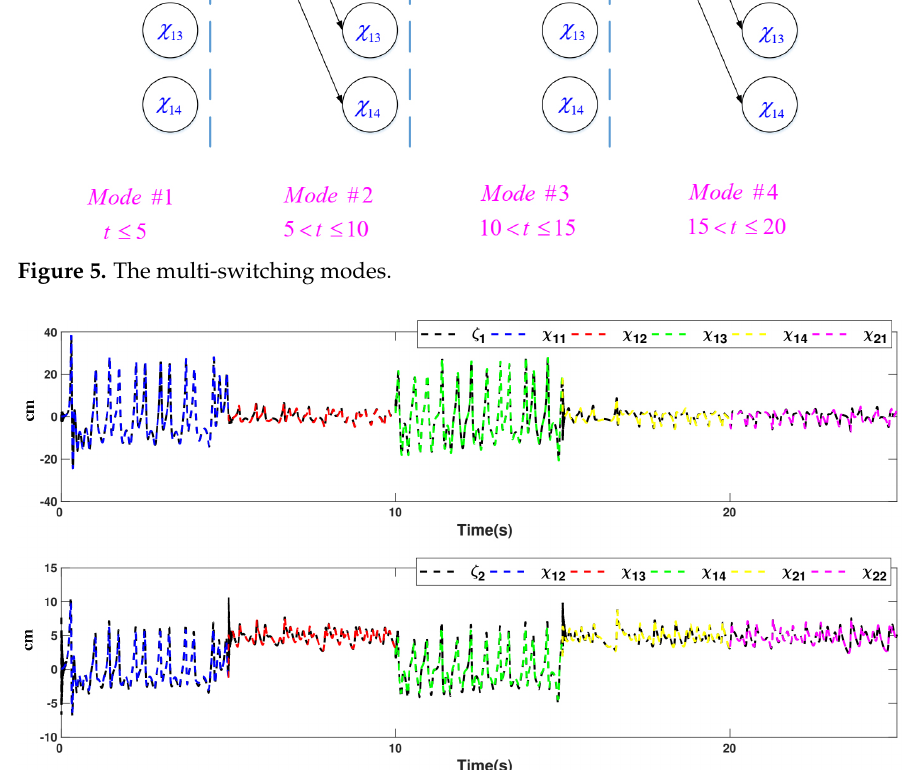
Figure 6. Outputs and